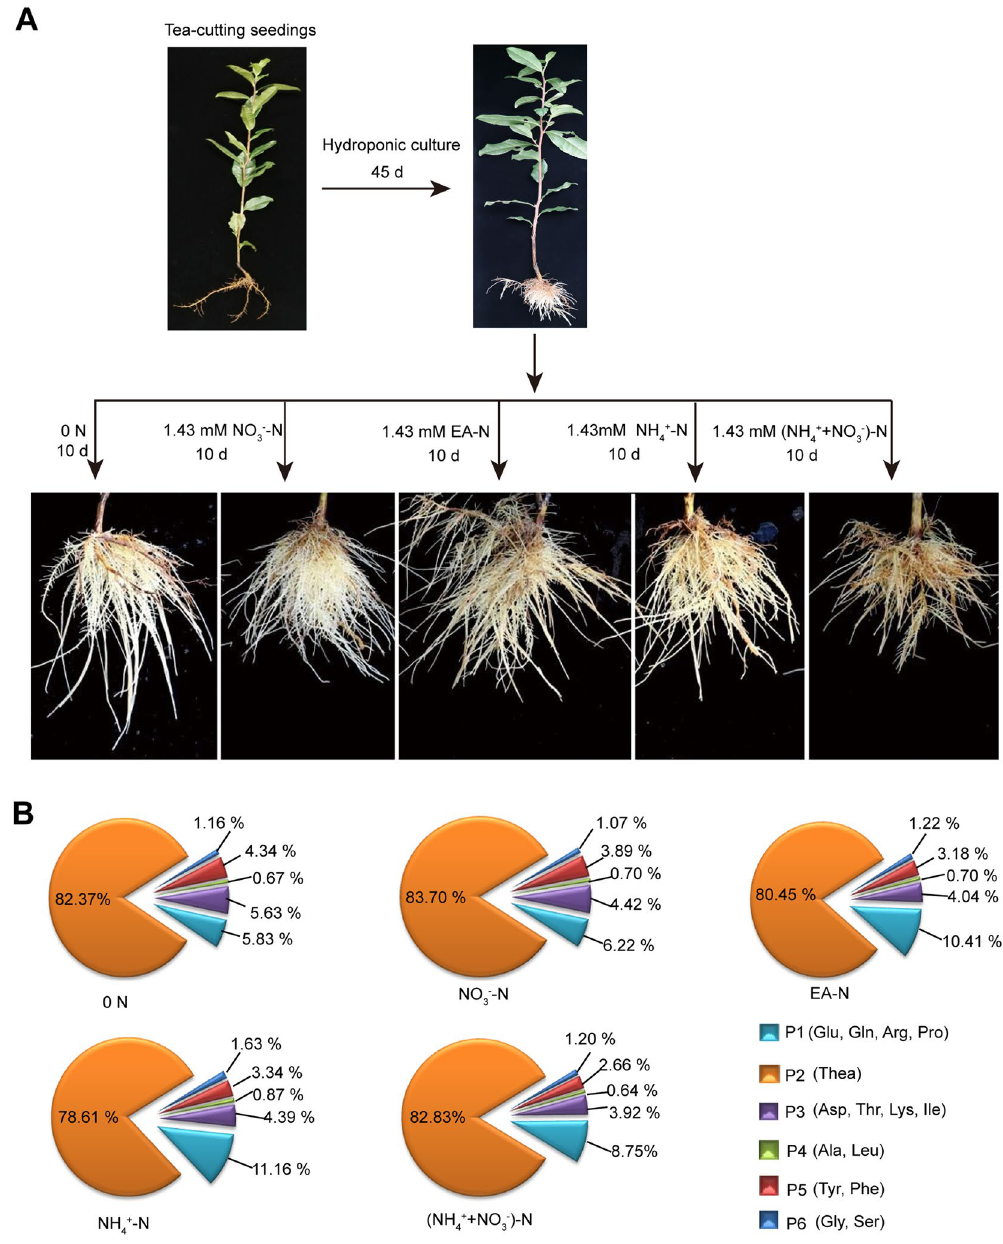
Figure 2. Schematic of experiment procedure and composition of amino acids in the tea plant roots under the treated conditions. ( A ) Two-year-old cuttings of tea plant were recorded after hydroponics cultivation for 45d in a basal nutrient solution. The roots morphologies were recorded under various N forms treatment for 10 d (see “Materials and Methods”). ( B ) Composition of amino acids in tea plant roots under different forms of N and 0 N treatments at time point of 10